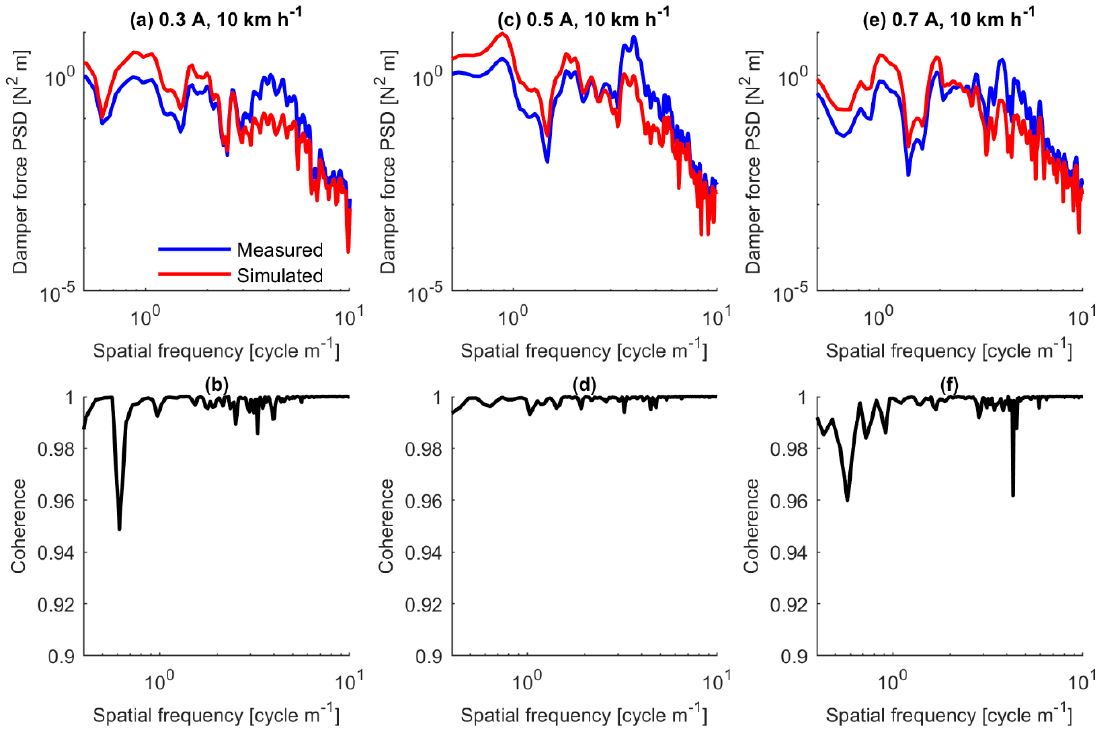
Figure 8. ( a , c , e ) Power spectral density (PSD) of the measured and the simulated damper forces when the MR damper was supplied with 0.3 A, 0.5 A, and 0.7 A and a traveling speed of 10 km h − 1 , and ( b , d , f ) the corresponding coherence.